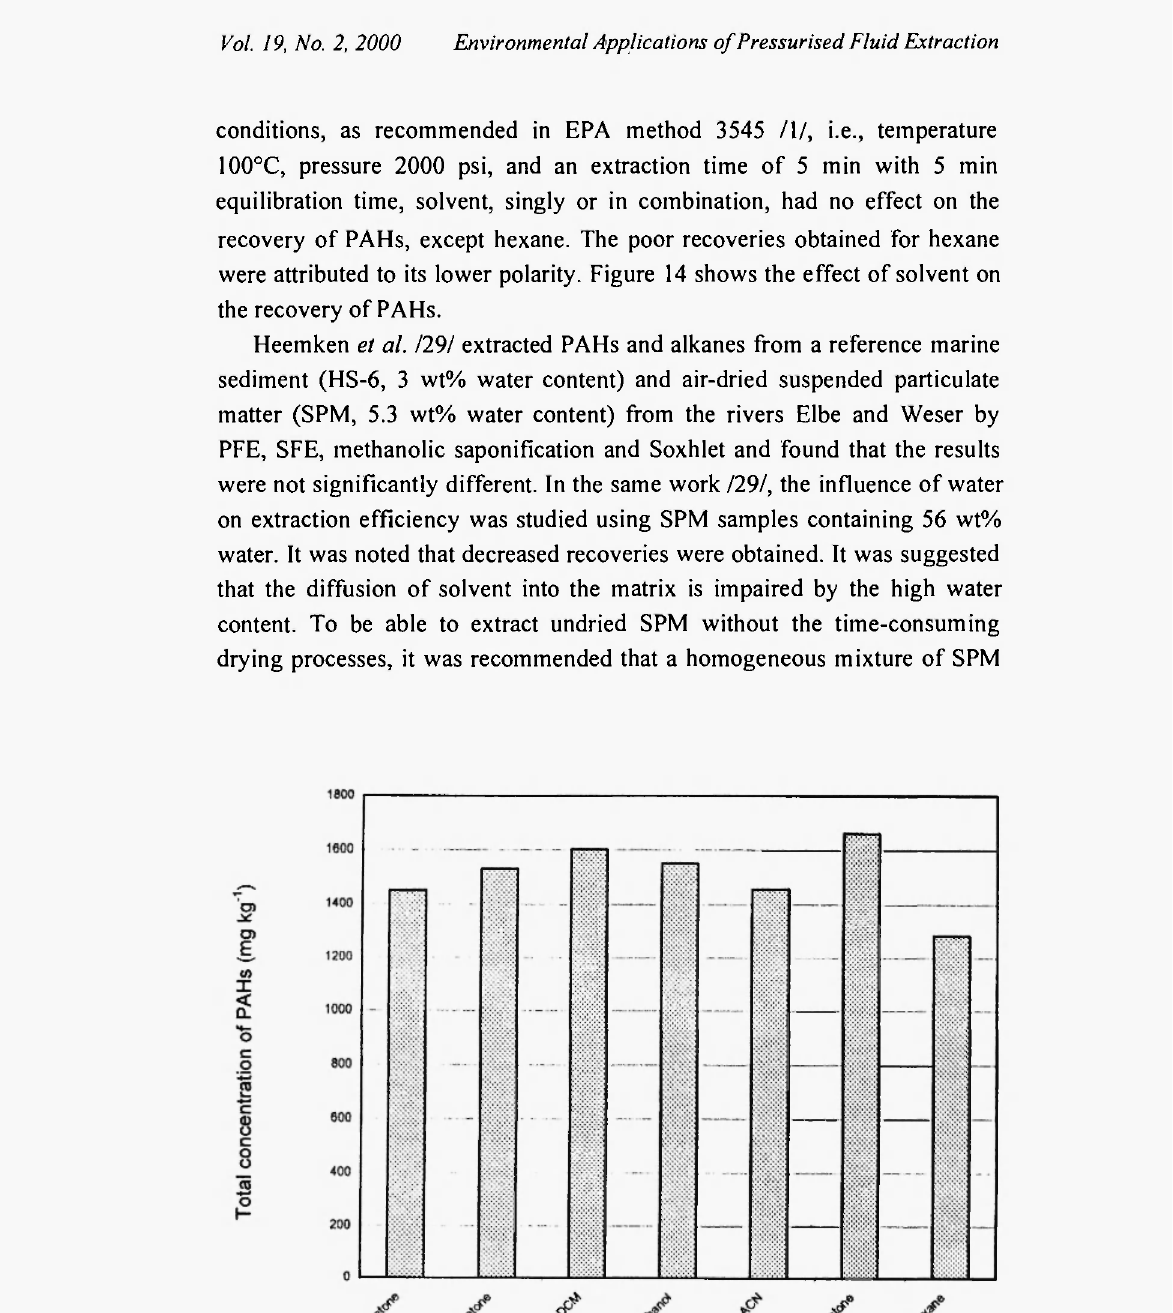
Fig. 14: Effect of solvent on the recovery of PAHs from a native contaminated